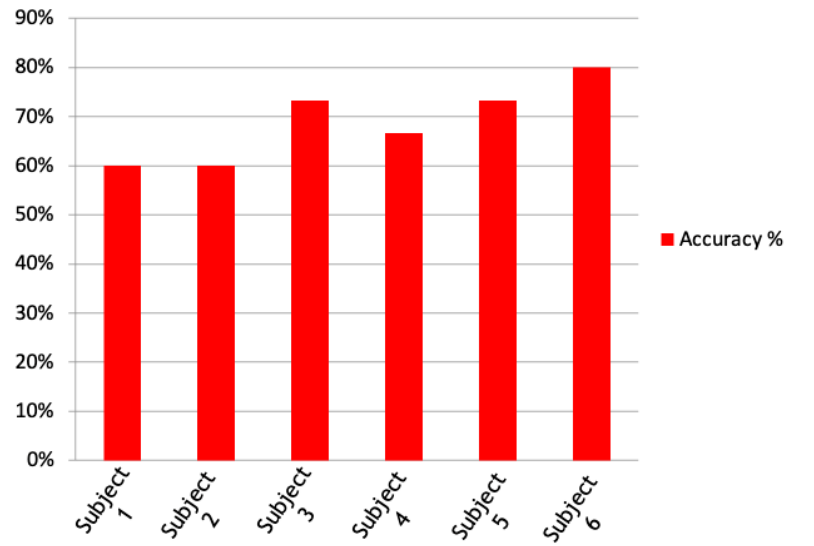
Figure 13. Accuracy results obtained from 6 different subjects involved in experimental sessions of 15 trials.